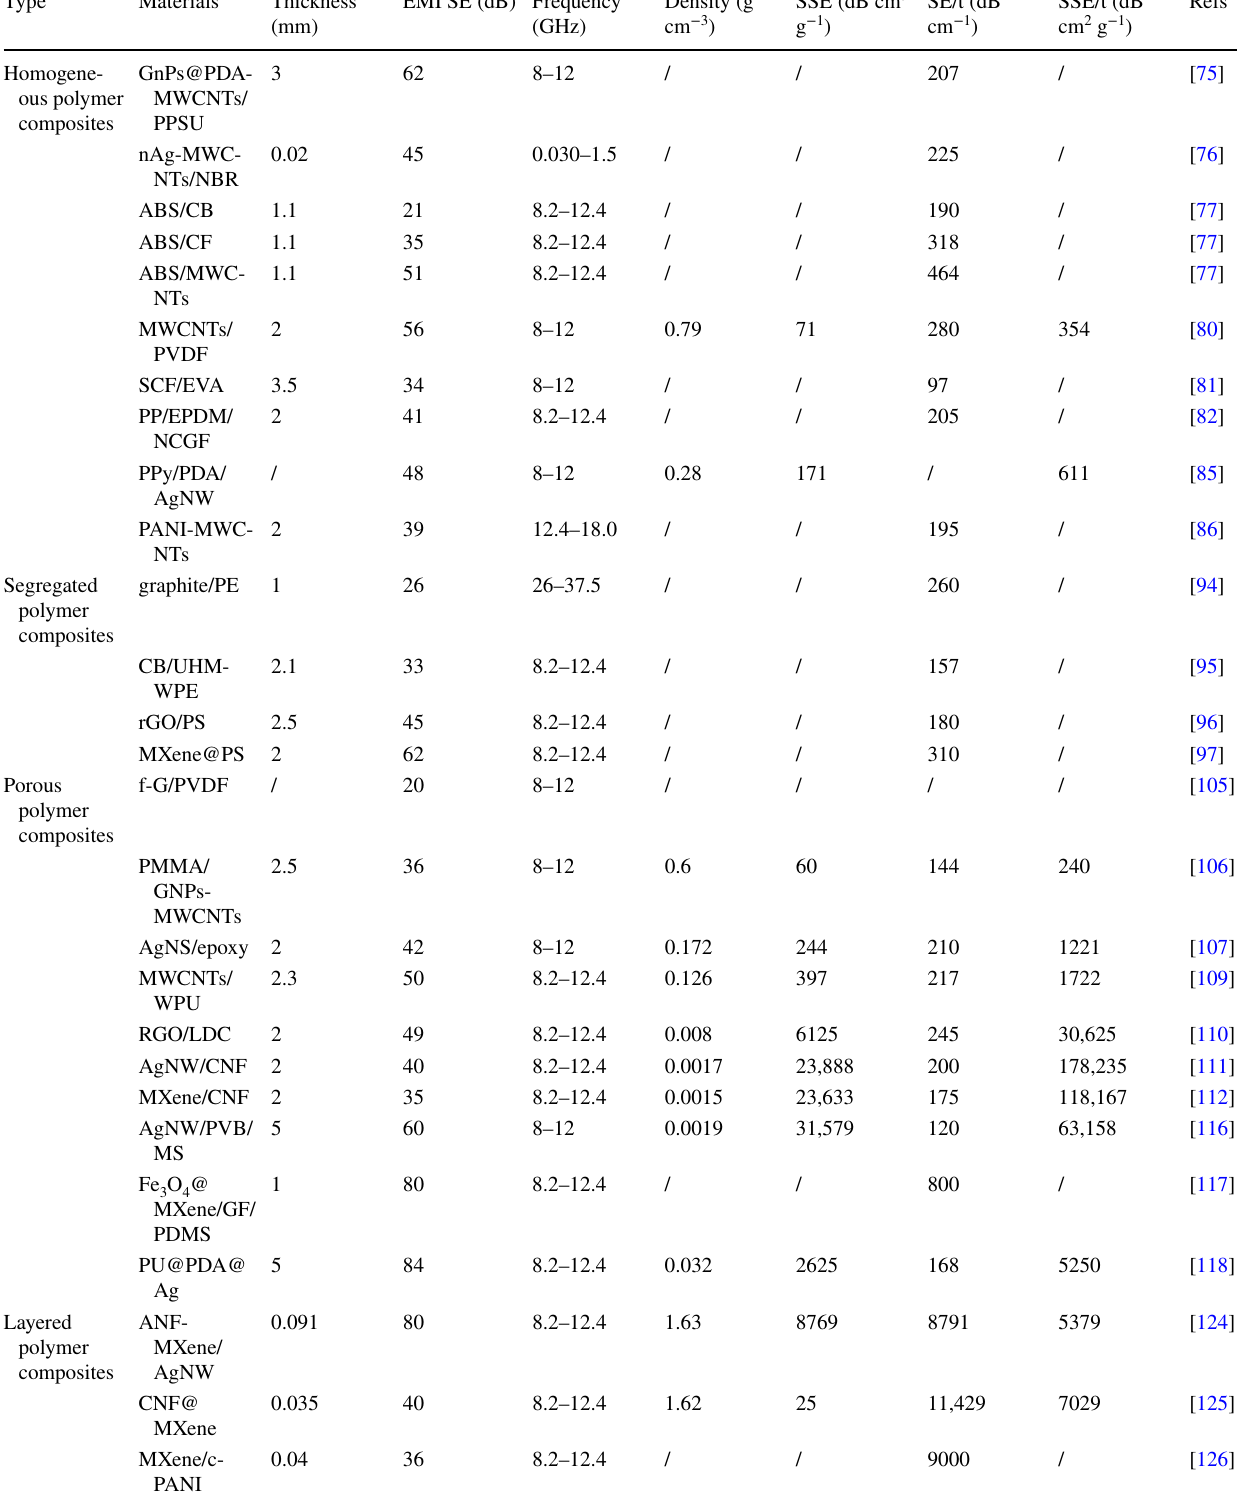
Table 1 Comparison of EMI shielding performances of the polymer matrix composites with different structures